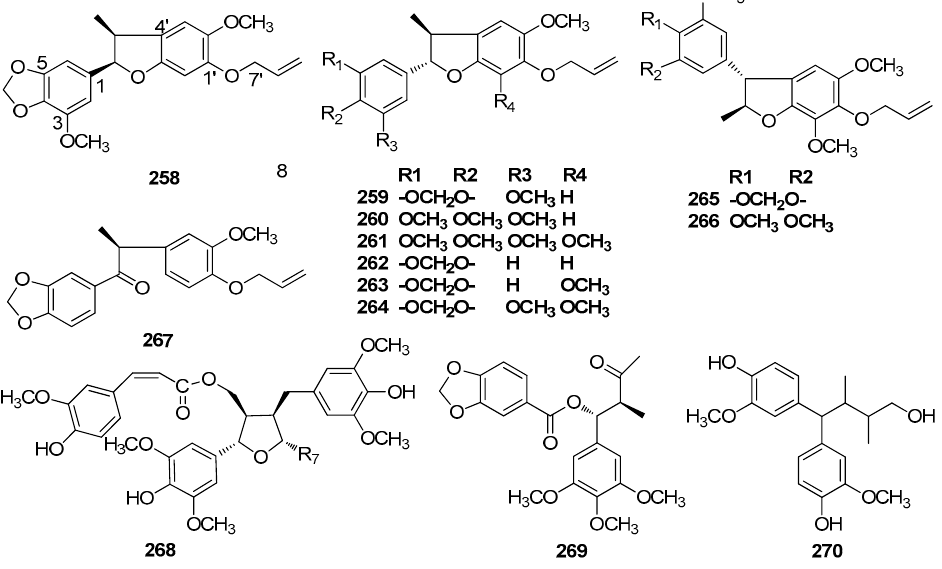
Figure 18. Chemical structures of uncommon neolignans.